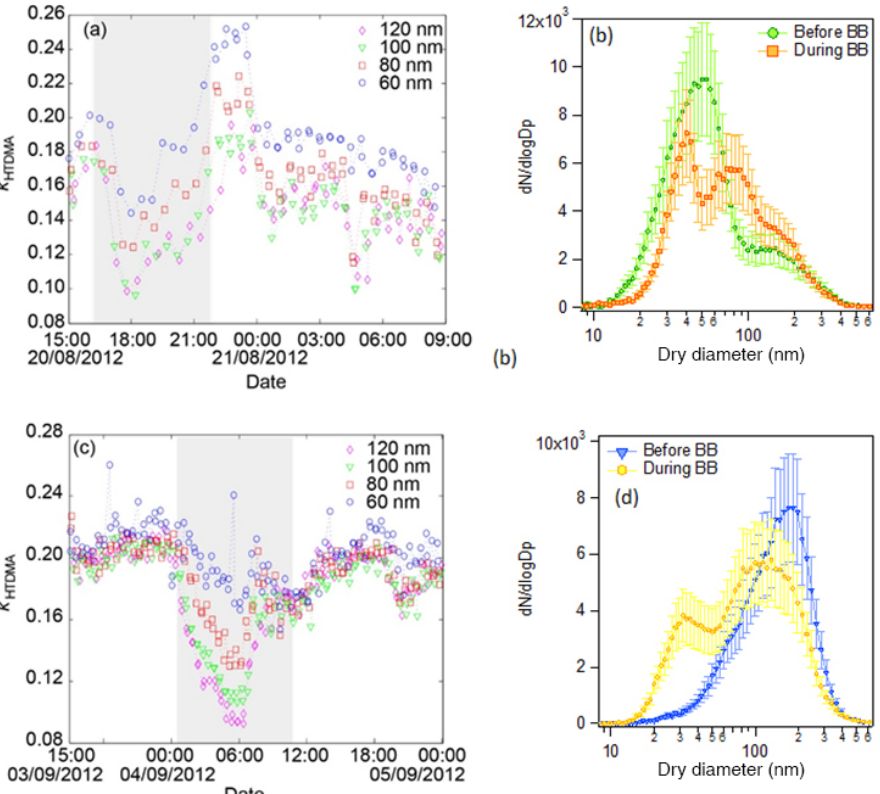
Figure 7. Hygroscopicity parameters derived from the HTDMA (a, c) and number size distributions from the SMPS (b, d) for the Chios and Euboea fire events, respectively. The shaded areas represent the smoke plume influence period.